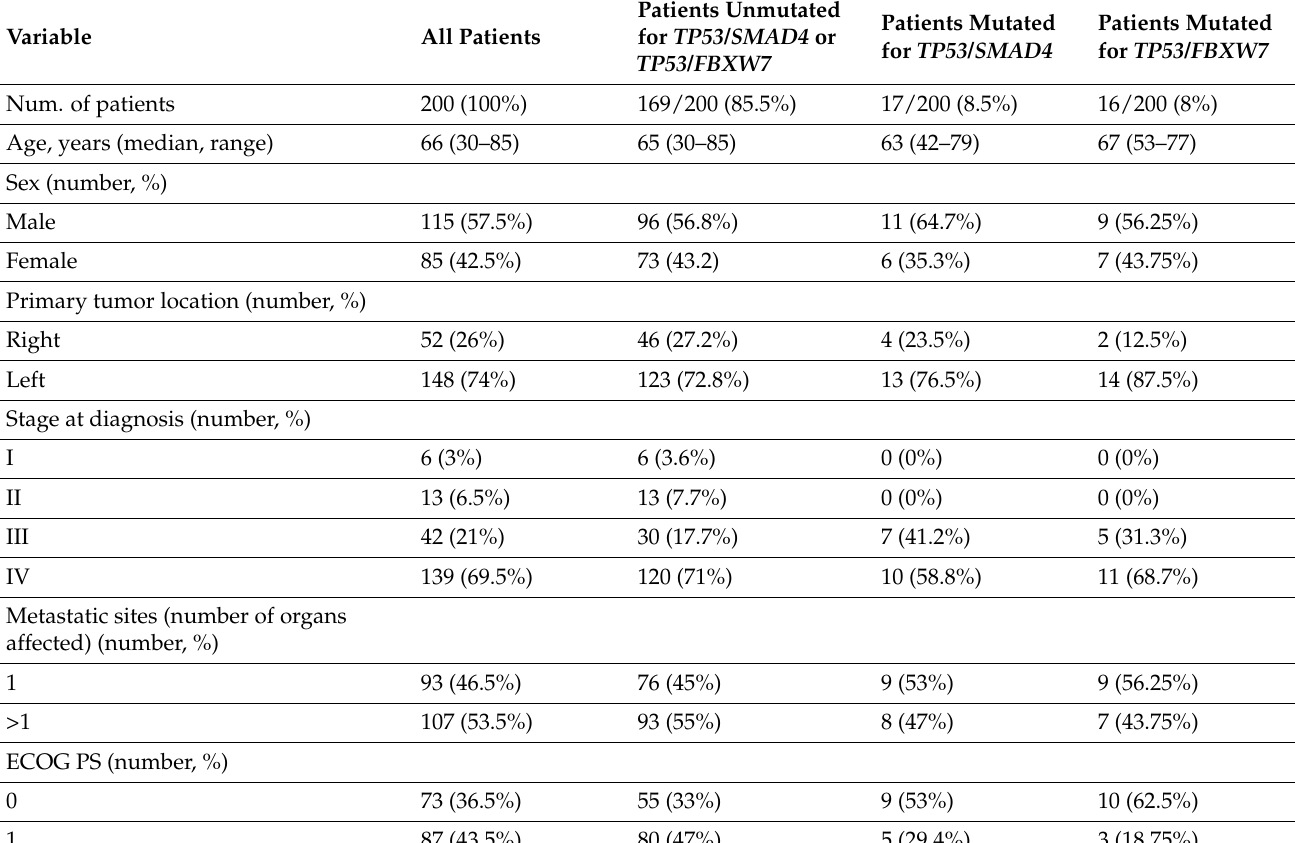
Table 1. Clinical description of our study